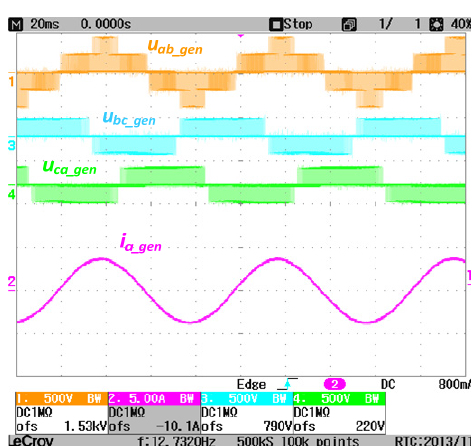
Fig. 11. Steady state of three-phase AC/DC part of converter. From top: phase to phase voltages of converter ( u ab_gen , u bc_gen , u ca_gen ) and generator phase current i a .